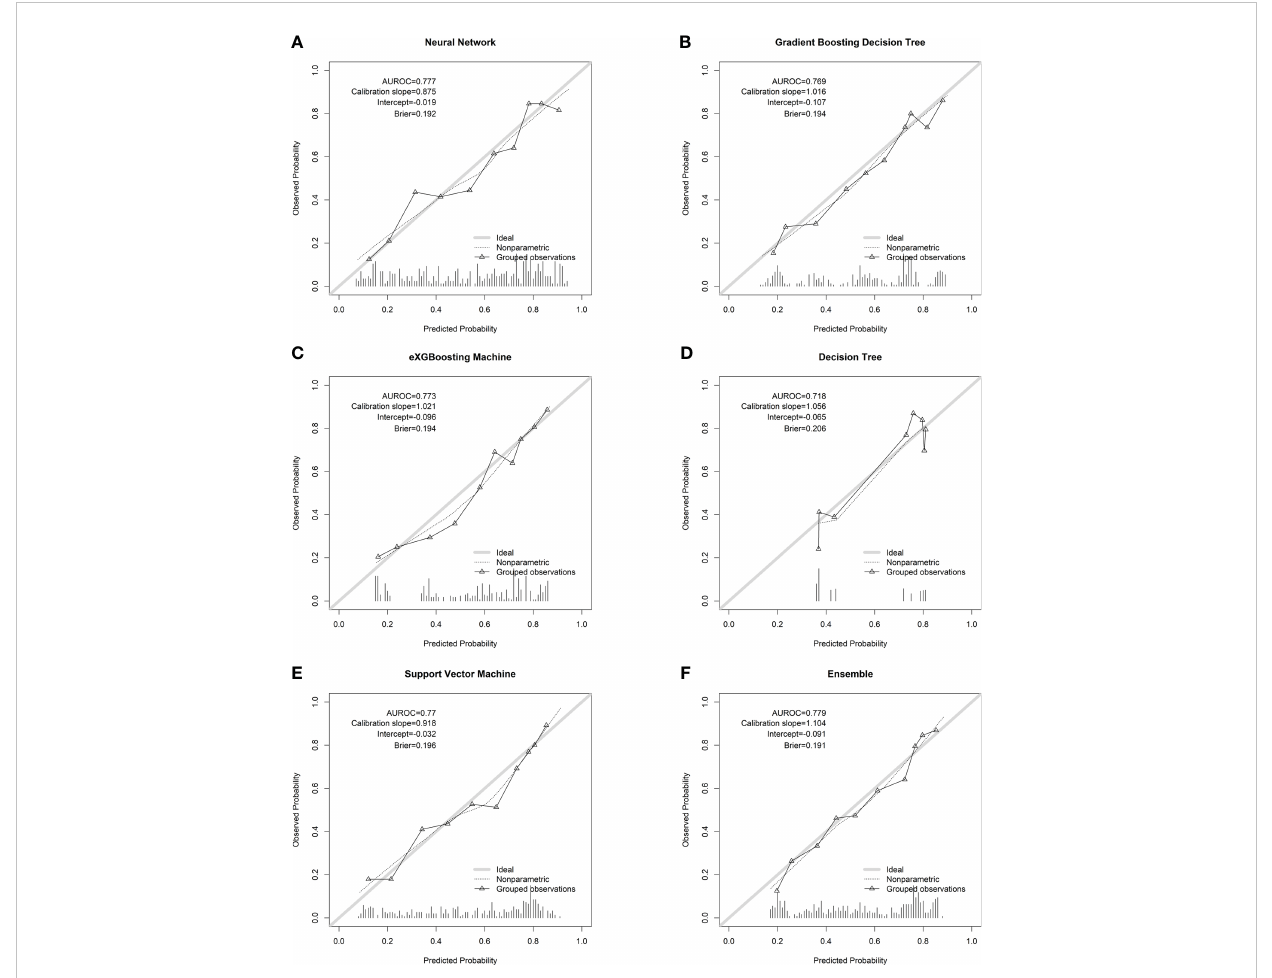
FIGURE 4 Calibration plots of the machine learning models in the internal testing cohort. (A) Neural network; (B) gradient boosting decision tree; (C) eXGBoosting machine; (D) decision tree; (E) support vector machine; (F) ensemble